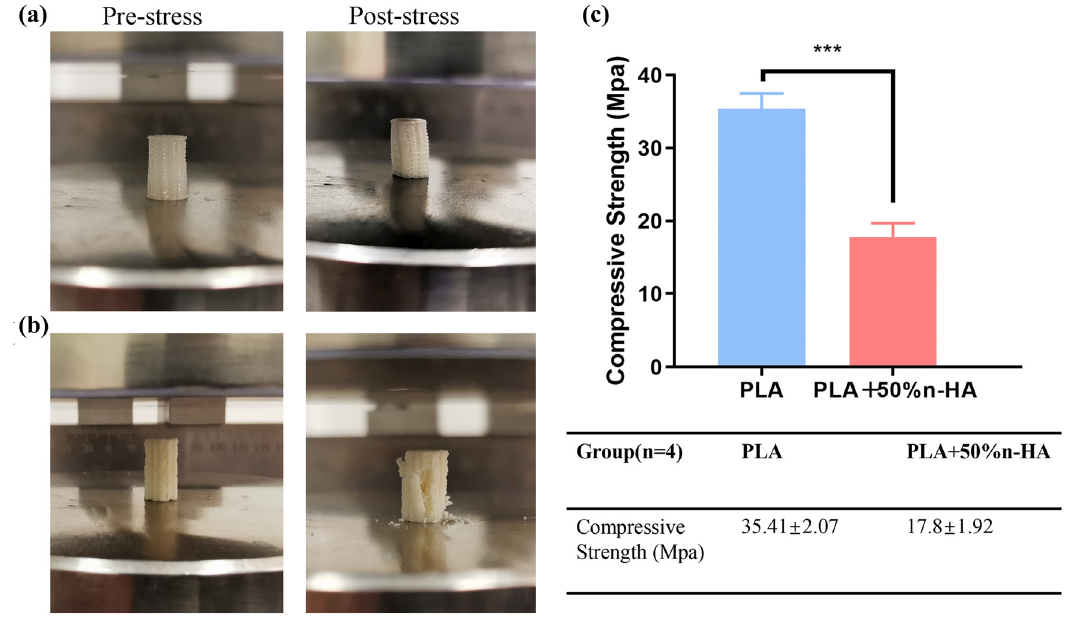
Figure 5: Mechanical test of 3D - printed samples. ( a ) 3D - printed PLA cylinder before pressure test and after pressure test; ( b ) 3D - printed PLA/n - HA cylinder before pressure test and after pressure test; and ( c ) pressure test results. *** p <